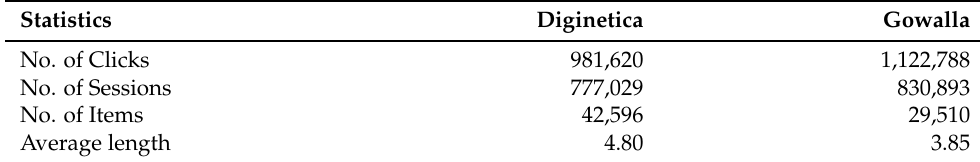
Table 2. Statistics of the datasets used in our